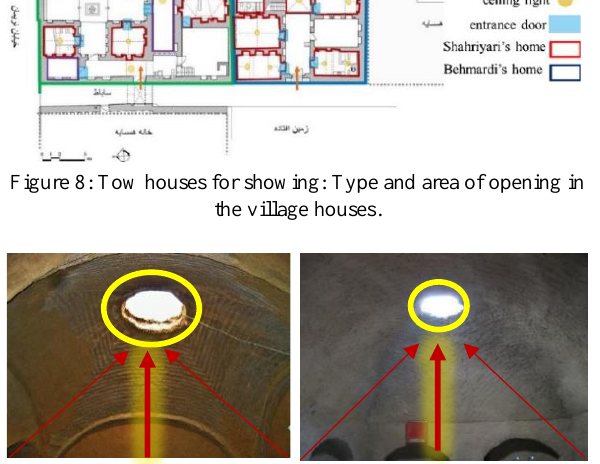
Figure 9. An examples of ceiling light in these houses.